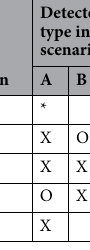
Detector position